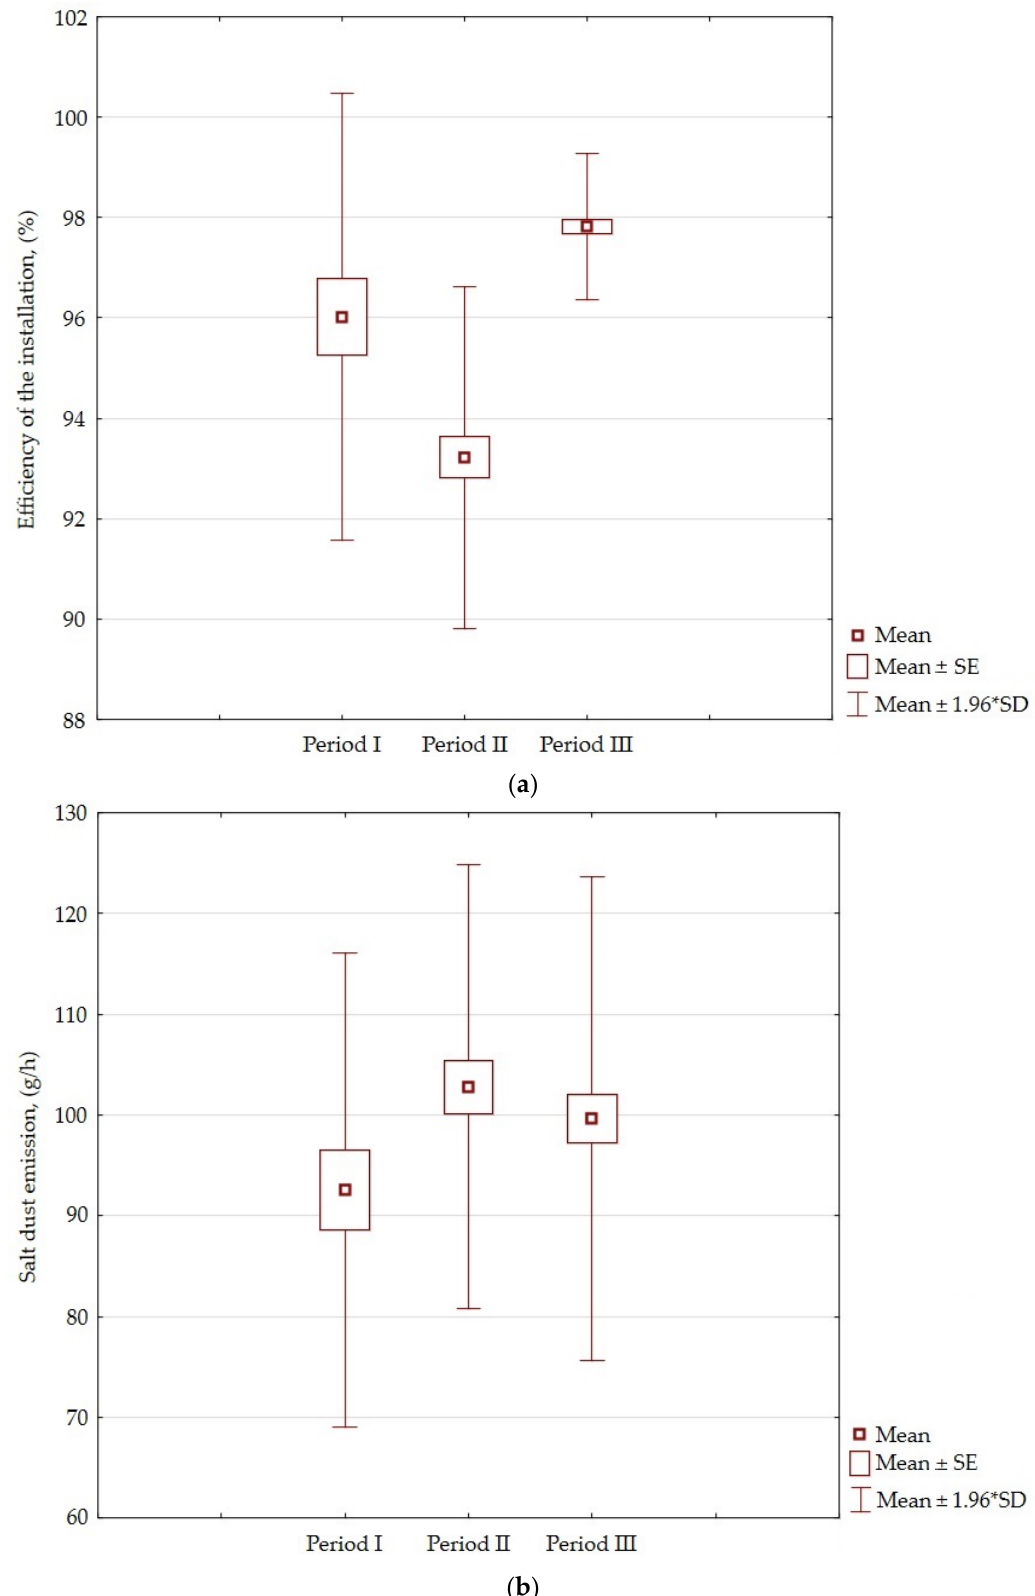
Figure 7. Three operating periods for the saltwork: ( a ) efficiency of the installation; ( b ) salt-dust emission; SE—standard error; SD—standard deviation.